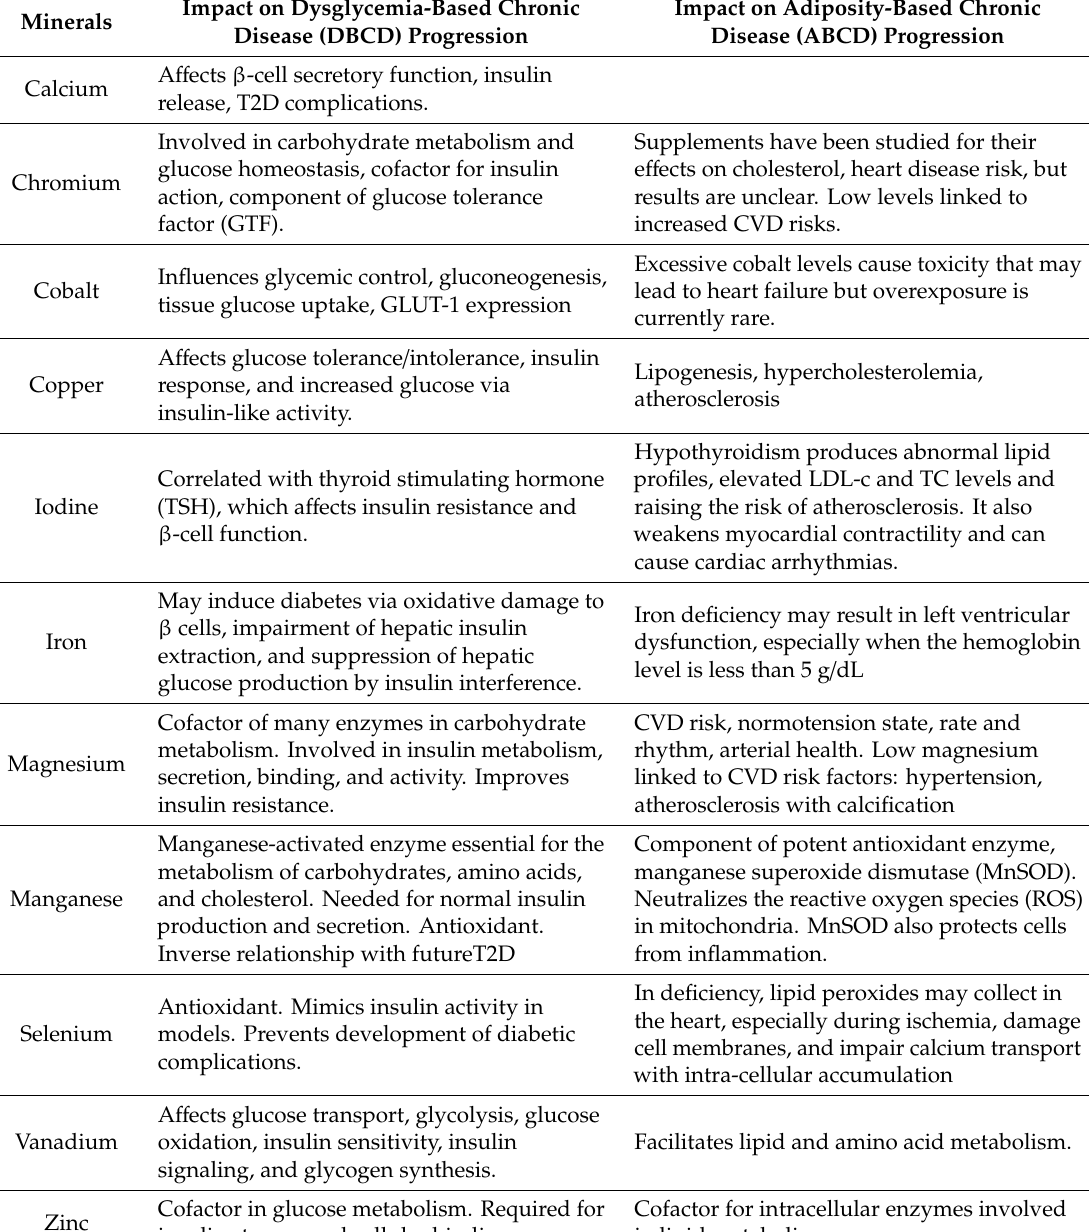
Table 1. Actions of minerals on various aspects of cardiometabolic-based chronic disease